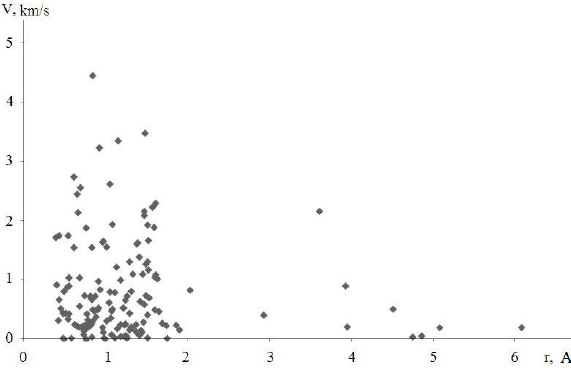
Figure 1. Dependence of the velocity V of the ejection of dust parti- cles of the anomalous tail on the heliocentric r distance.